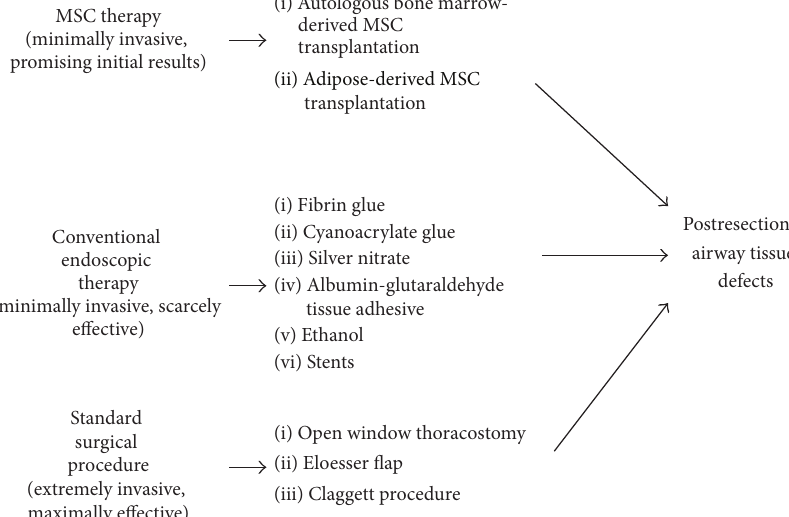
feasible in the treatment of ARDS [65] as well as in a phase I clinical trial disclosing that a single intravenous infusion of allogeneic, bone marrow-derived human MSCs was well tolerated in nine patients with moderate to severe ARDS